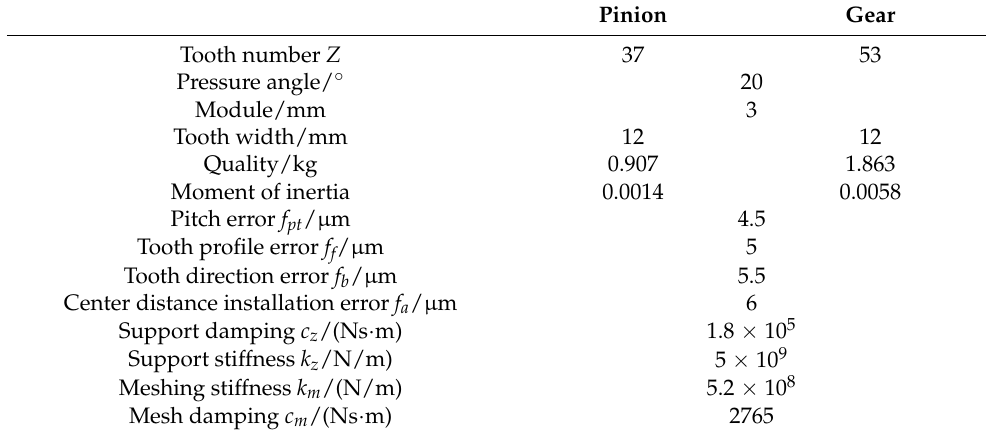
Table 1. Basic parameters of gears.